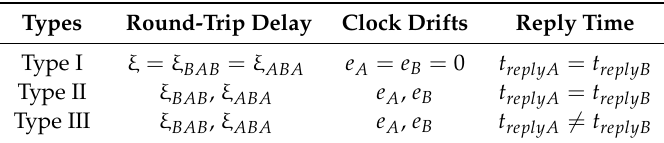
Table 1. Three assumption types for time-of-flight (TOF) Classification Errors ( c (cid:13) 2018 IEEE. Reprinted with